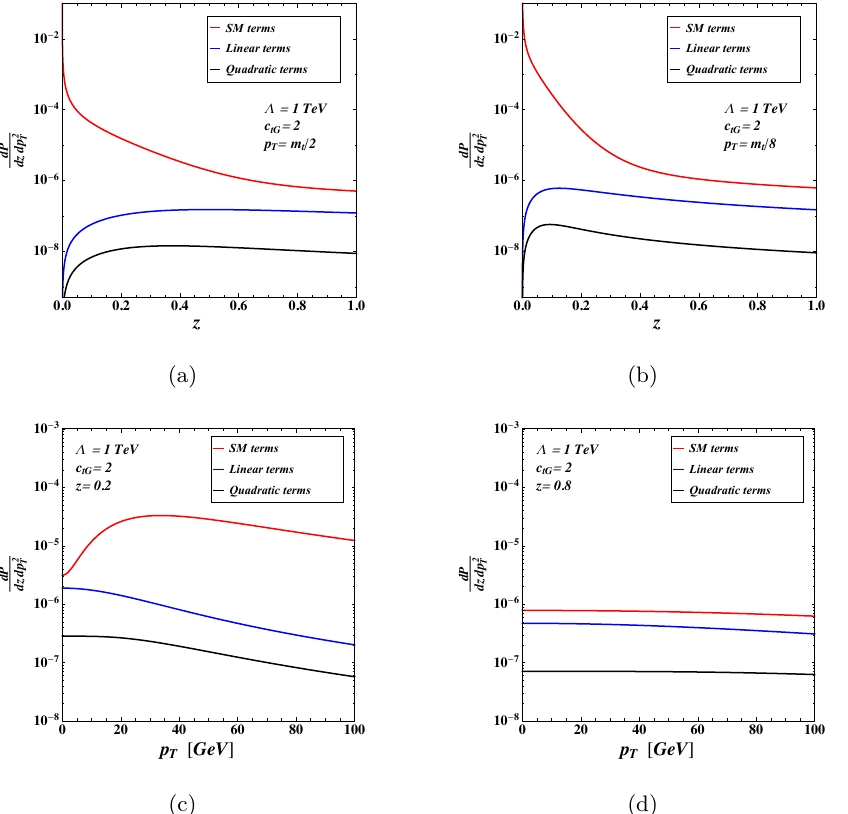
Figure 3 . Splitting functions for the SM, the interference, and the quadratic EFT pieces in figure 1. The splitting functions in terms of z variable for fixed (a) p splitting functions in terms of p choose c = 2 and Λ = 1 t G